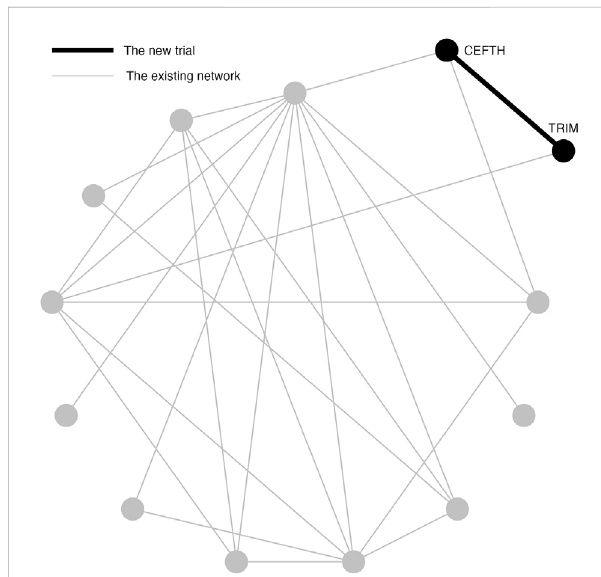
FIGURE 1 An existing network of interventions for the treatments of Bovine Respiratory Disease (BRD) in feedlot cattle with a new study between CEFTH(A) and TRIM(B) where A and B had no direct comparison in the existing